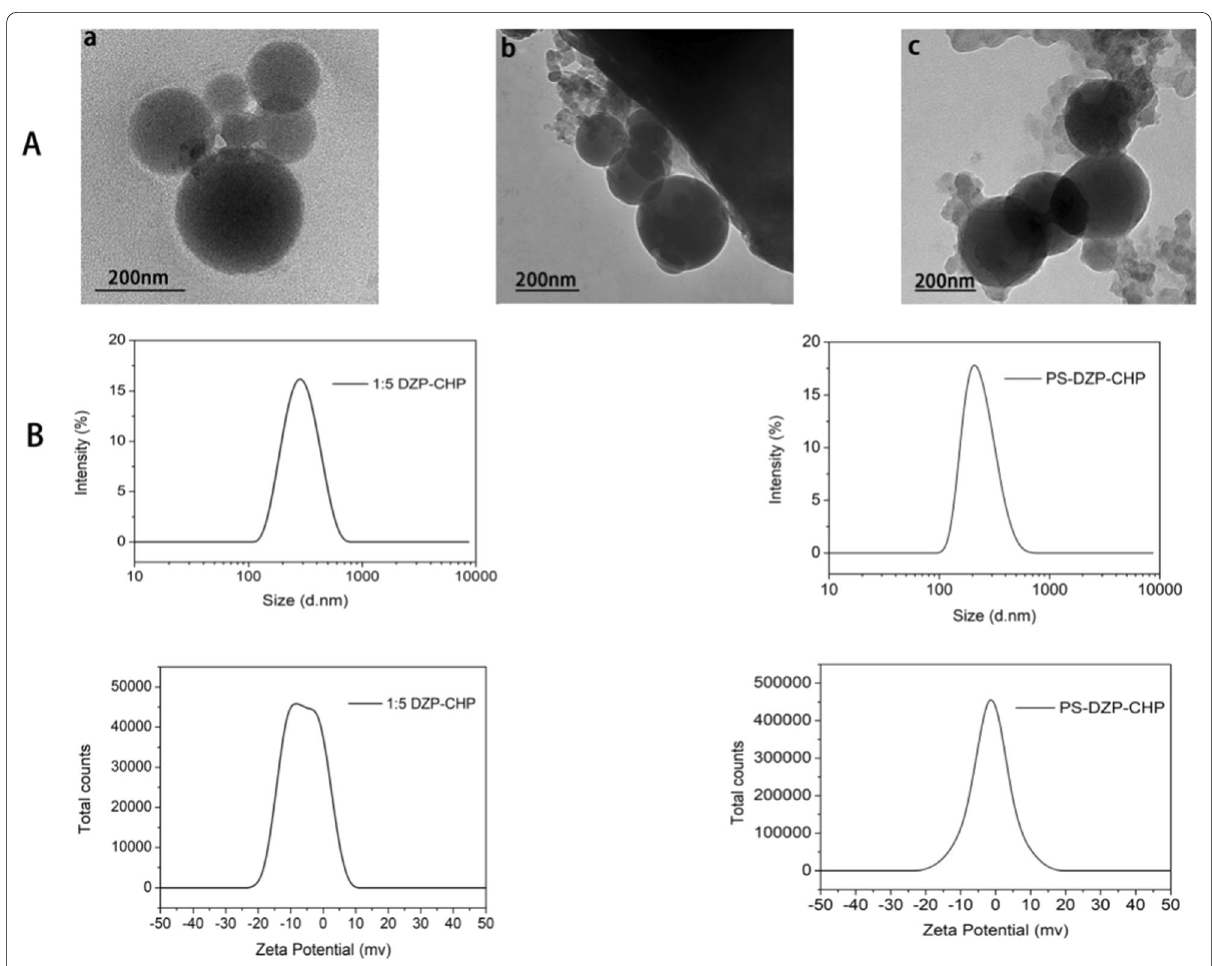
Fig. 3 Characterization of different nanoparticles. a a Transmission electron microscopy photograph of CHP NPs, b transmission electron microscopy photograph of DZP-CHP NPs, c transmission electron microscopy photograph of PS-DZP-CHP NPs. B: Particle size diagram and zeta potential diagram of CHP-DZP NPs (feed ratio 1: 5) and DZP-CHP NPs modified with polysorbate 80 (feed ratio 1: 5)